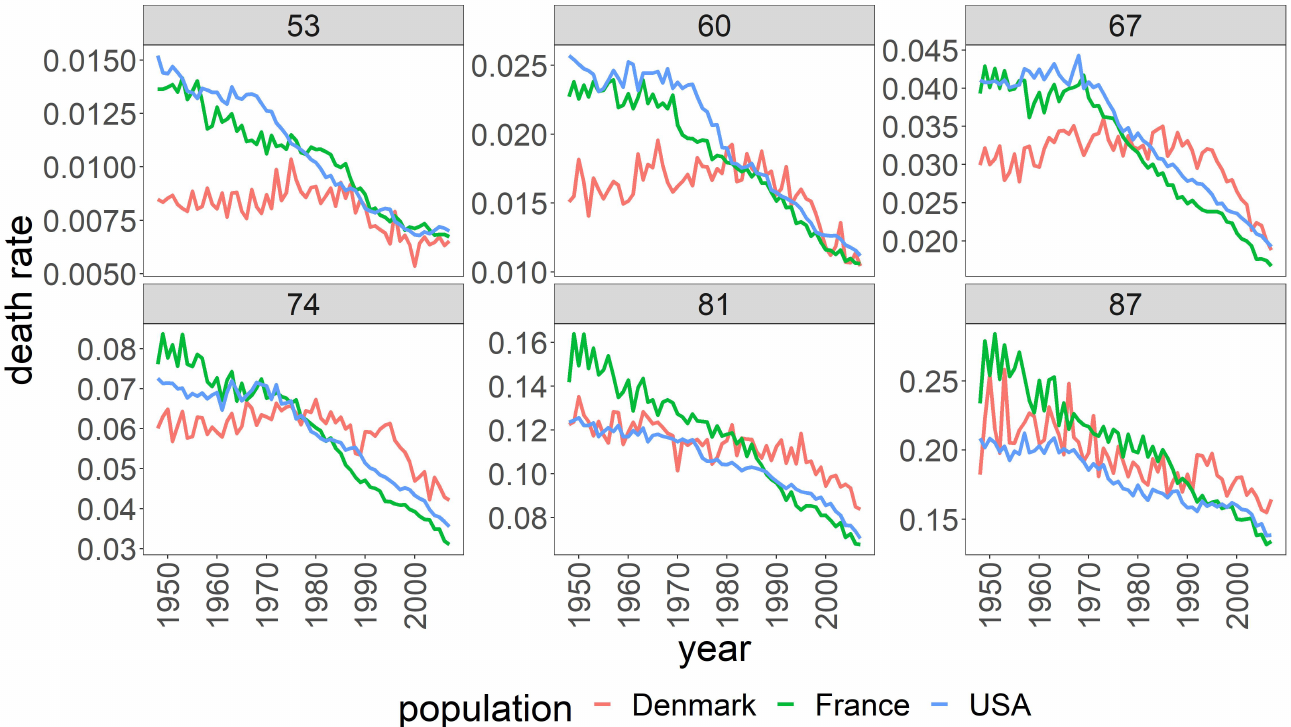
Figure 2. Death rates for males aged 53, 60, 67, 74, 81 and 87 in Denmark, France and the USA between 1948 and 2007 (note the differing